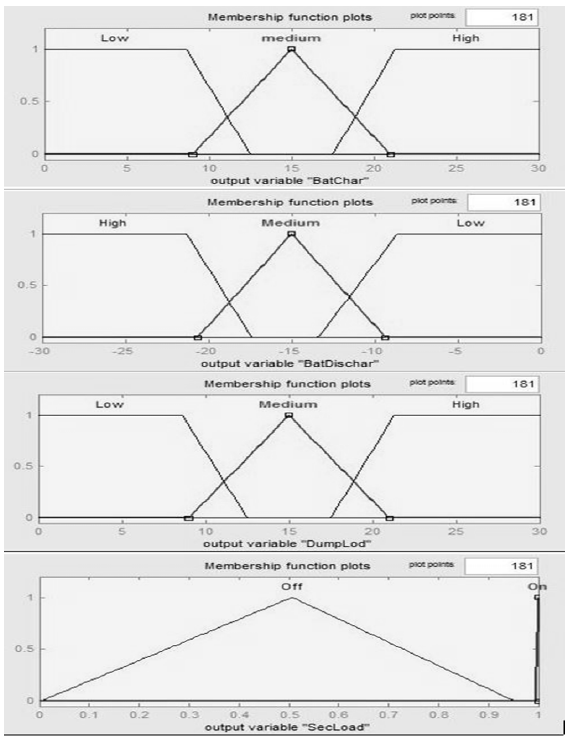
Figure 10 . Membership functions for output variables.